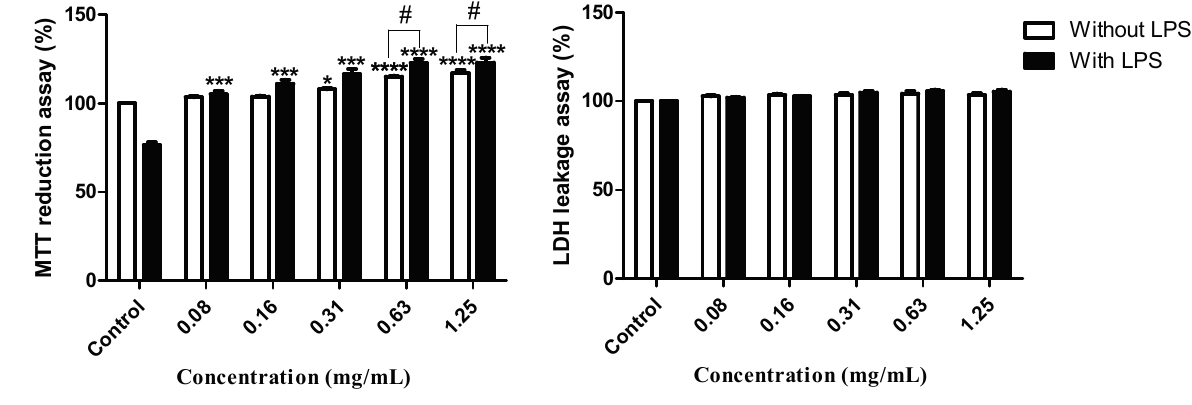
Figure 4. Viability of RAW 264.7 cells pre-treated for 1 h with methanol extract, followed by 18 h co-treatment with lipopolysaccharide (LPS) or LPS vehicle. Results are presented as mean ± standard error of the mean of five independent experiments, performed in